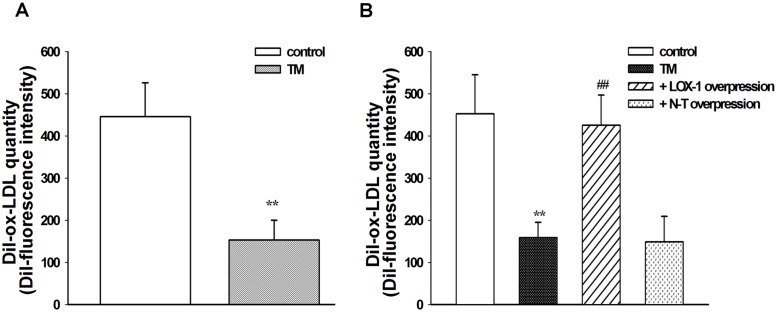
Impact of LOX-1 overexpression on lipid uptake capability in TM-treated hepatic L02 cells.A: Flow cytometric analysis of DiI-ox-LDL uptake capability in L02 cells before (control) or after 24 h TM treatment. Mean fluorescence intensity is presented. B: Cells were transfected with pCMV6-XL5-LOX-1 plasmid (LOX-1 overexpression) or pCMV6-XL5 empty vector (N-T mock transfection control) for 24 h before treatment with TM (1 μg/mL). Untransfected cells in the absence of TM were used as a control. These data are representative of three independent experiments. **P < 0.01 vs. control; ## P < 0.01 vs. TM treatment alone. TM: tunicamycin.